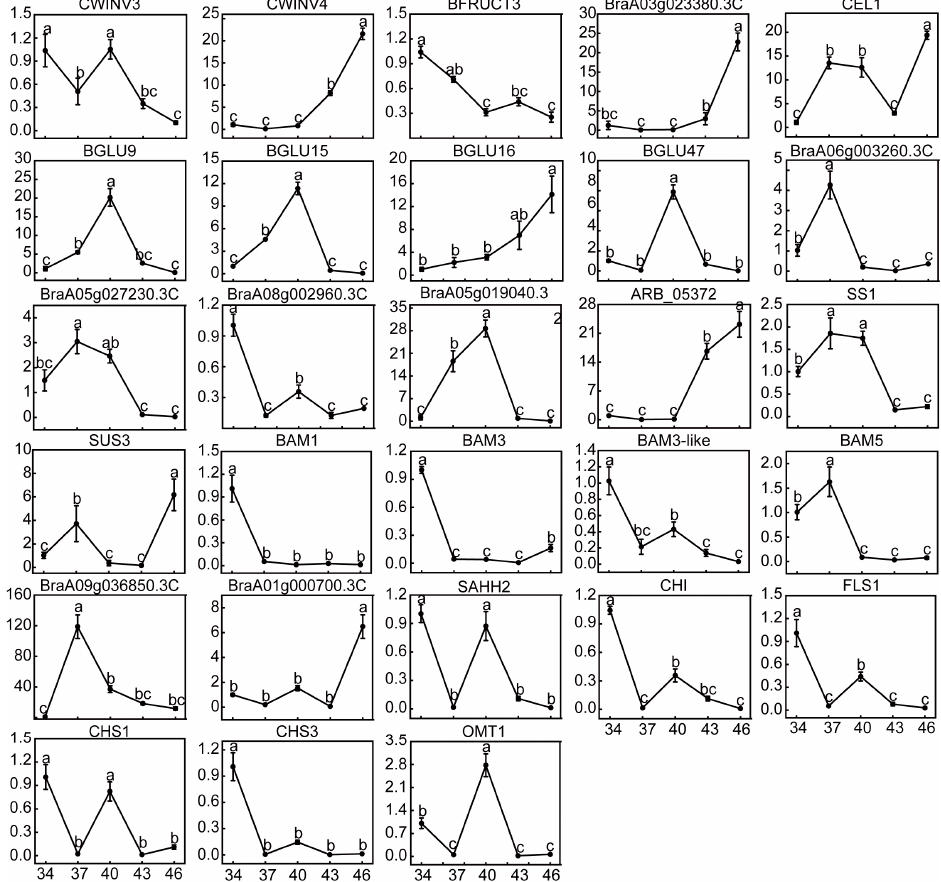
Figure 7. Relative expression level of DEGs during wucai ripening. The values obtained by the quantitative real-time PCR (qRT-PCR) represent the mean ± SE of three replicates. Bars with different letters are significantly different at p < 0.05.